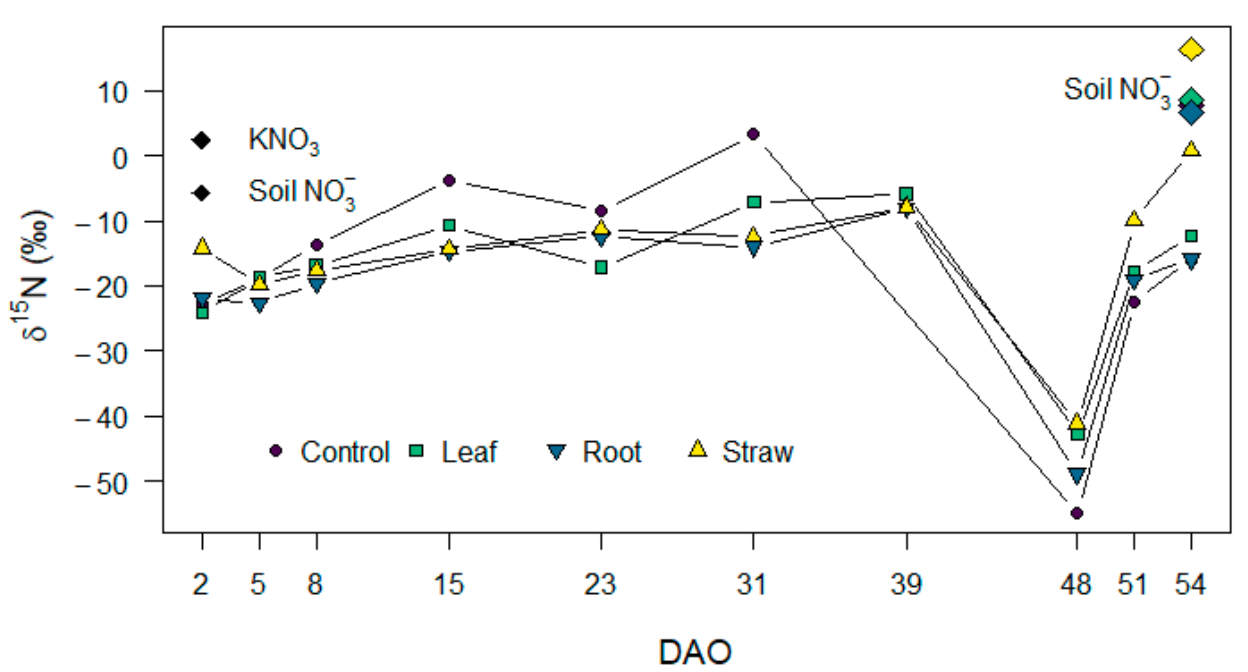
Figure 4. δ 15 N bulk of N 2 O (colored symbols and lines), added KNO 3 and soil NO 3 − at first day of incubation (black symbols) and soil NO 3- at last day of incubation (colored symbols with black borders) (means for n = 5, n = 4 for Control).